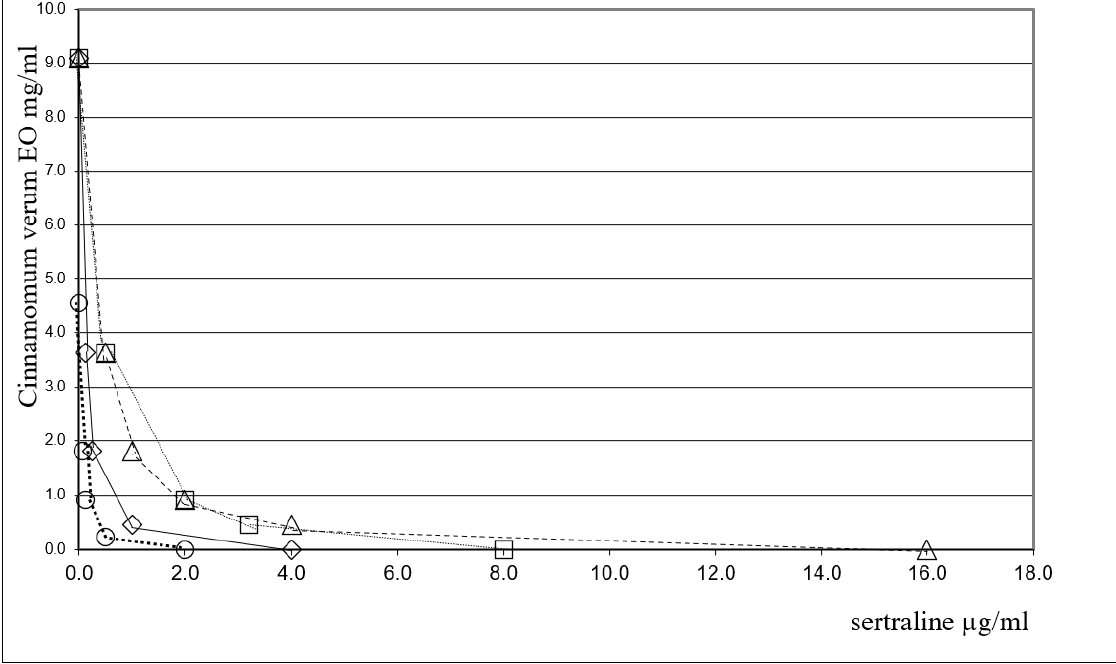
Figure 2. Isobole curves revealing the synergistic effect of sertraline with CEO in inhibiting four bacterial strains. E. coli ATCC 25922, S. aureus ATCC 29213, B. subtilis ATCC 6633, S. au- reus ATCC 6538P. 3. Discussion